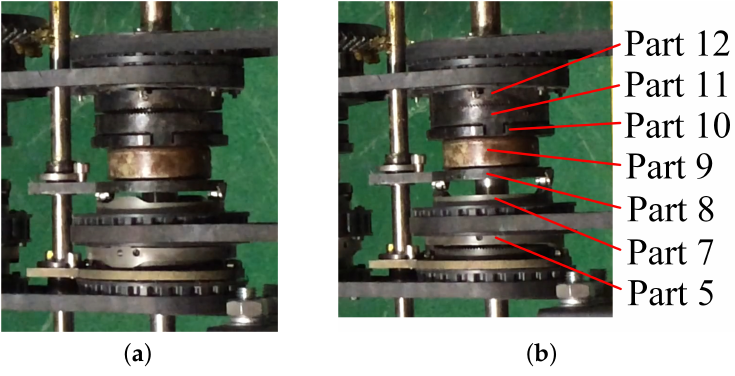
Figure 26. The experiment of the PSU. ( a ) The PSU is in switched off status. ( b ) The PSU is in switched on